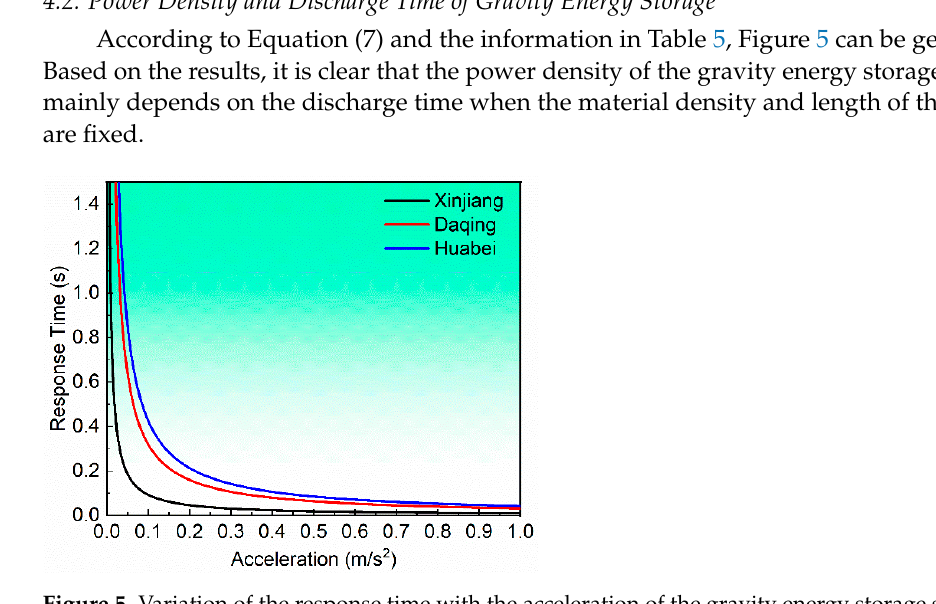
Figure 5. Variation of the response time with the acceleration of the gravity energy storage system in the three major oilfields.